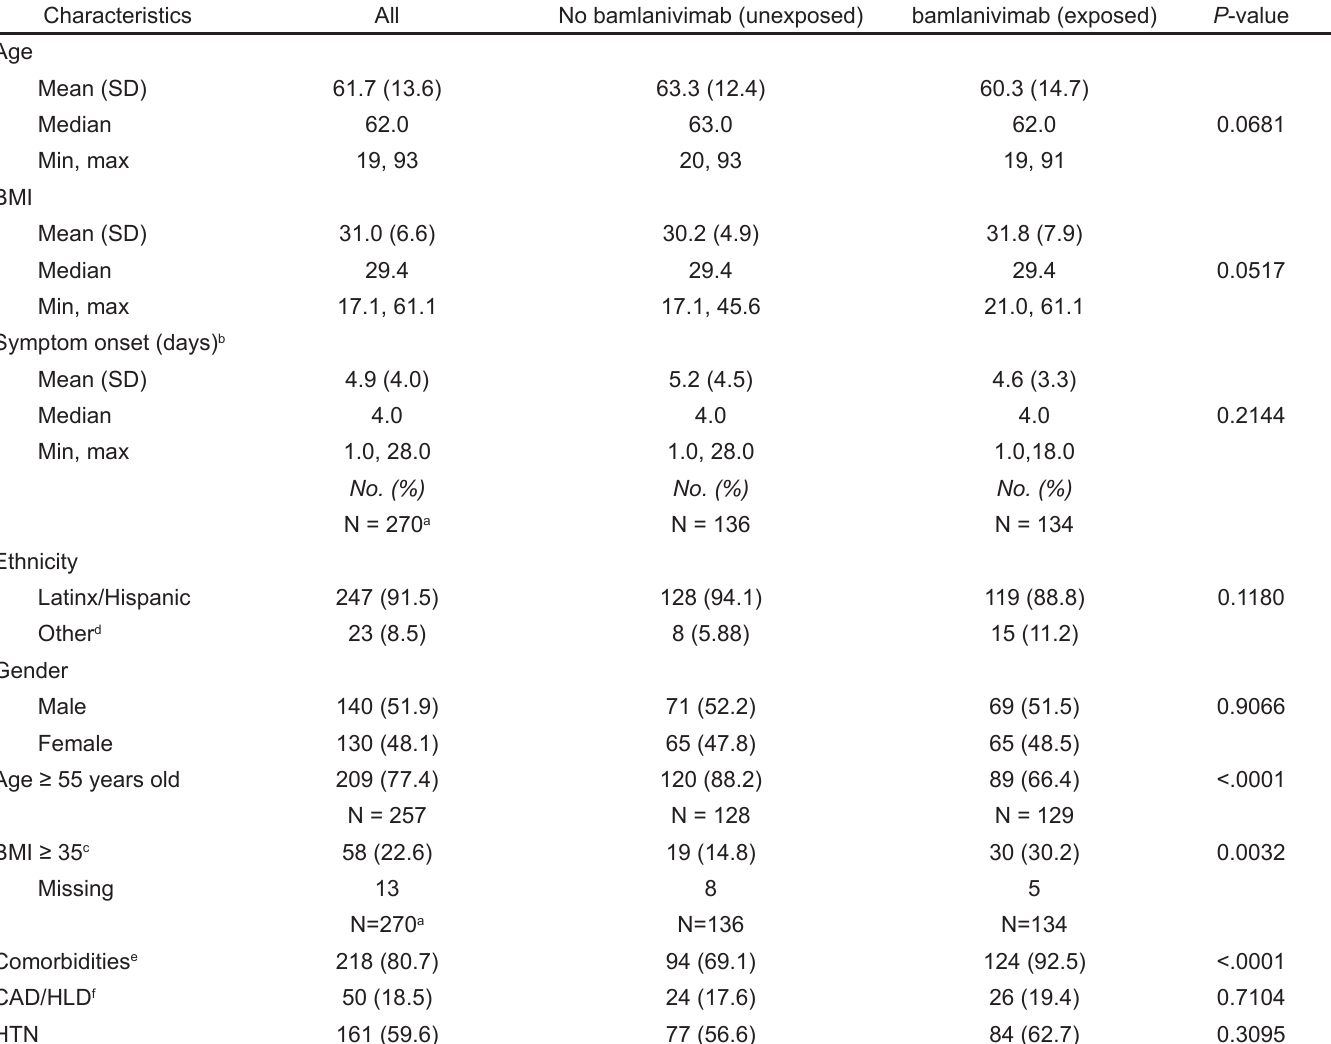
Table 1. Demographics and characteristics of COVID-19 emergency department patients, comparing no bamlanivimab exposure vs bamlanivimab